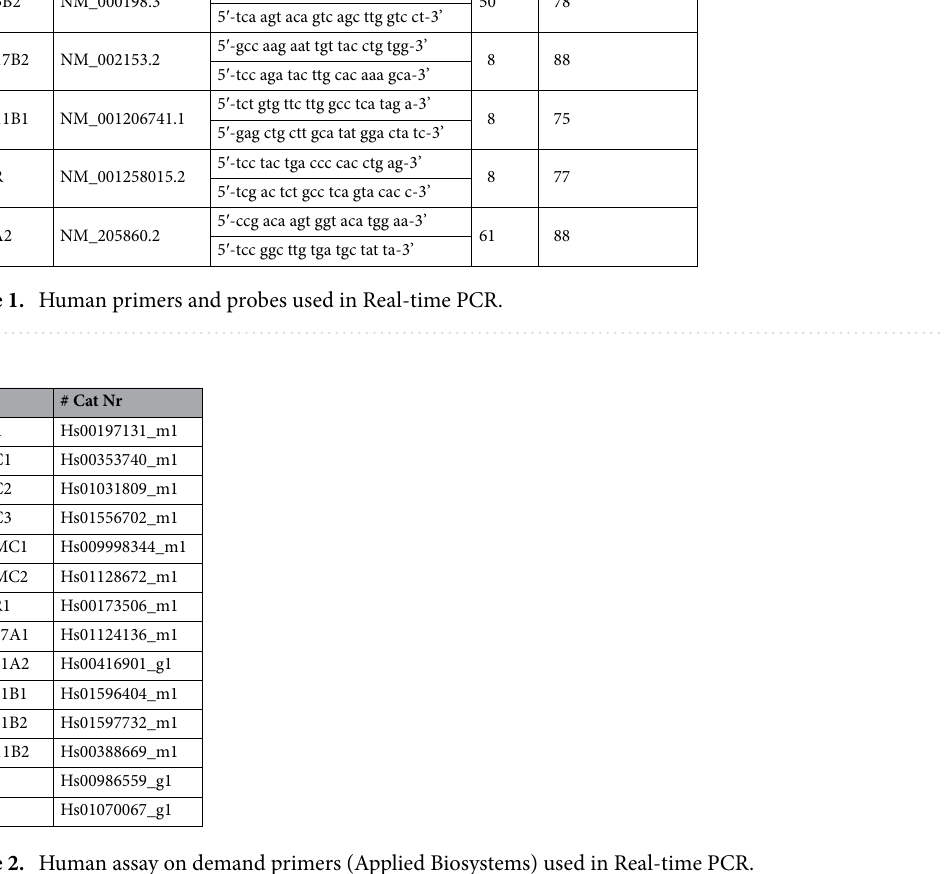
Table 2. Human assay on demand primers (Applied Biosystems) used in Real-time